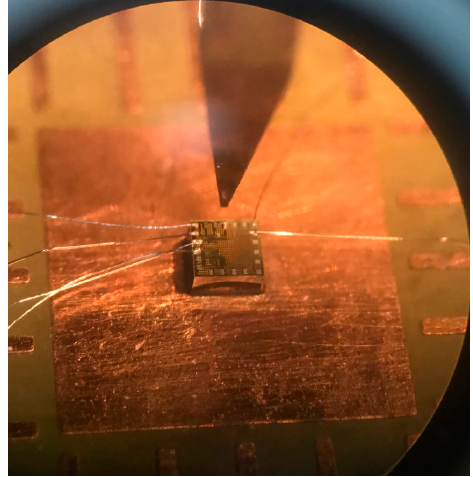
Figure 10. Picture of the MS chip in wire-bonding.